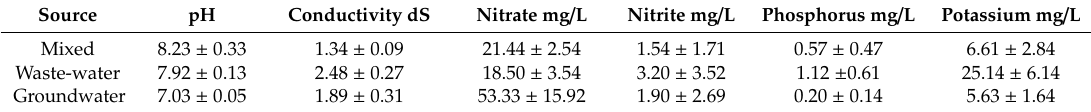
Table 3. Water quality data for the field measurements in the three di ff erent water